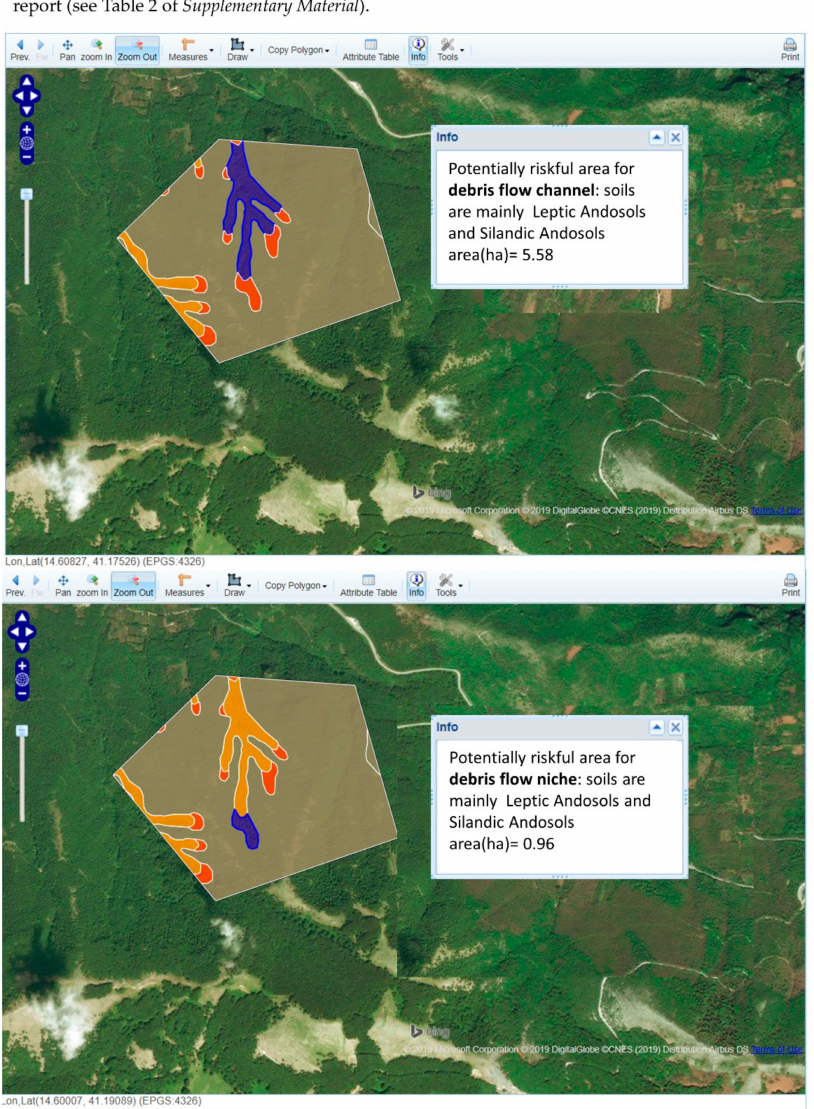
Figure 6. Results from two simulations produced with the GIFT tool. Two identical AOI have been generated and defined as areas to be managed. The tool is capable of identifying potentially risky areas according to the soil and geomorphologic types. This information can be used by private forest to obtain prior authorization for forest